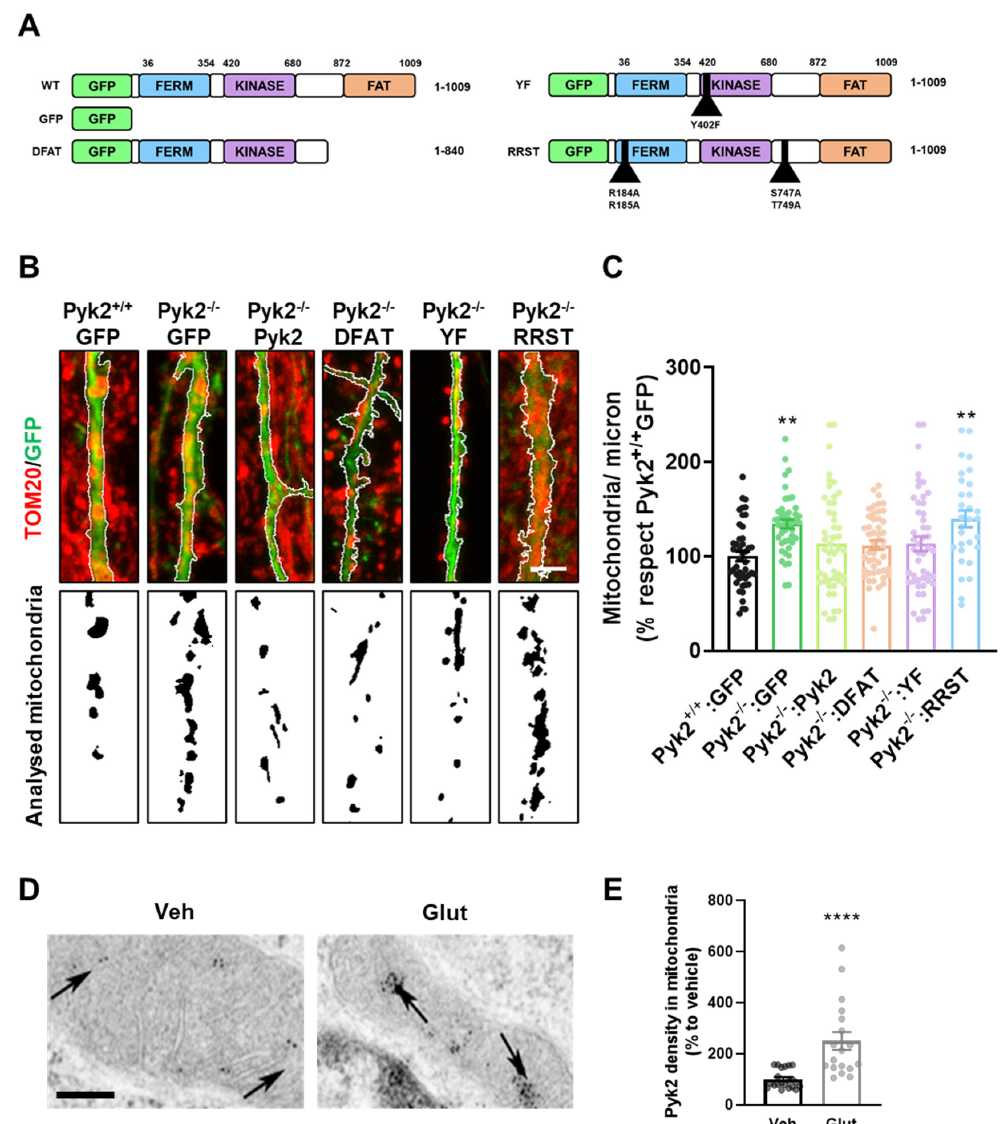
Figure 7. Mechanisms of Pyk2-dependent modulation of mitochondrial density. ( A ) Cultured hippocampal neurons were transfected with plasmids expressing only GFP or Pyk2 or Pyk2 with the indicated mutations namely: DFAT (Pyk2 without the entire FAT domain), YF (Pyk2 with a point mutation in the tyrosine 402 residue for an alanine) and RRST (with four-point mutations in the import/export nuclear domains called R184A, R185A, S747A and T749A); ( B ) Hippocampal primary neurons from Pyk2 +/+ and Pyk2 − / − mice at 21 DIV. In the upper panel, immunostaining of TOM20 (red) and GFP expressed by the plasmids (green). In the lower panel, correspondent binary image with the analysed mitochondria in black with white background. Scale bar, 3 microns; ( C ) Quantification of number of mitochondria as in ( B ) (one-way ANOVA, F (5, 258) = 4.881, p = 0.0003). Tukey’s multiple comparisons test was used as a post hoc. Tukey’s post hoc p values are: ** p < 0.01 vs. Pyk2 +/+ :GFP group; n = 35–40 neurons/group from 4 different cultures; ( D ) Pyk2 presence (gold particles) in the mitochondria of Pyk2 +/+ cultured hippocampal neurons upon vehicle or glutamate treatment for 15 min (40 µ m, electronic microscopy imaging). Scale bar, 0.1 µ m; ( E ) Quantification of results (relative to vehicle group) as in ( D ) (Mann–Whitney test, ( A , B ) = 271, 259, U = 40; **** p < 0.0001). n = 21/20 mitochondria/group from 7 different cultured pyramidal neurons/group. Data are means ±